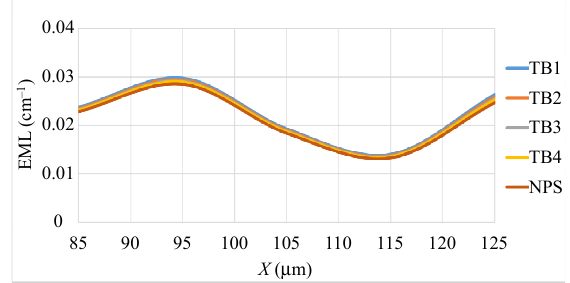
Fig. 5 EML of the proposed sensor for various samples infected with tuberculosis versus X at 2.2 THz.